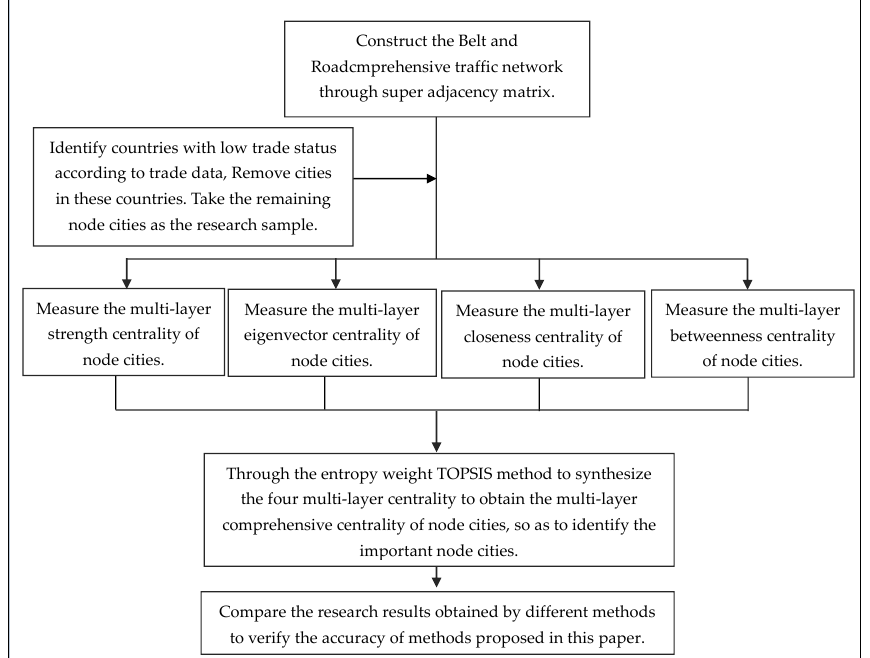
Figure 2. Technical routes.